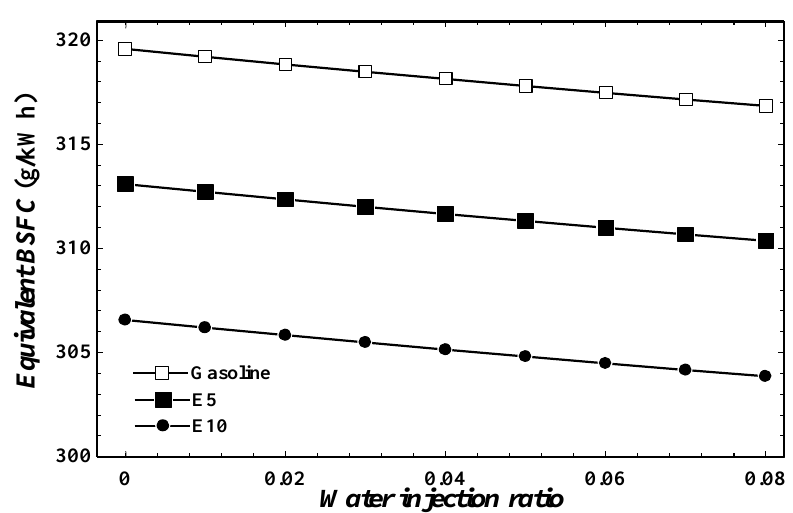
Figure 9. Engine equivalent BSFC in various water injection ratios for each fuel.